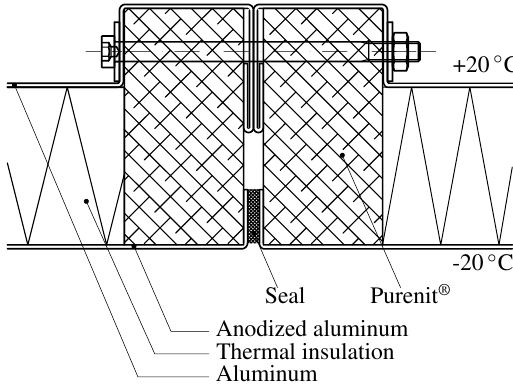
Figure 9. Mechanical design of the icing wind tunnel